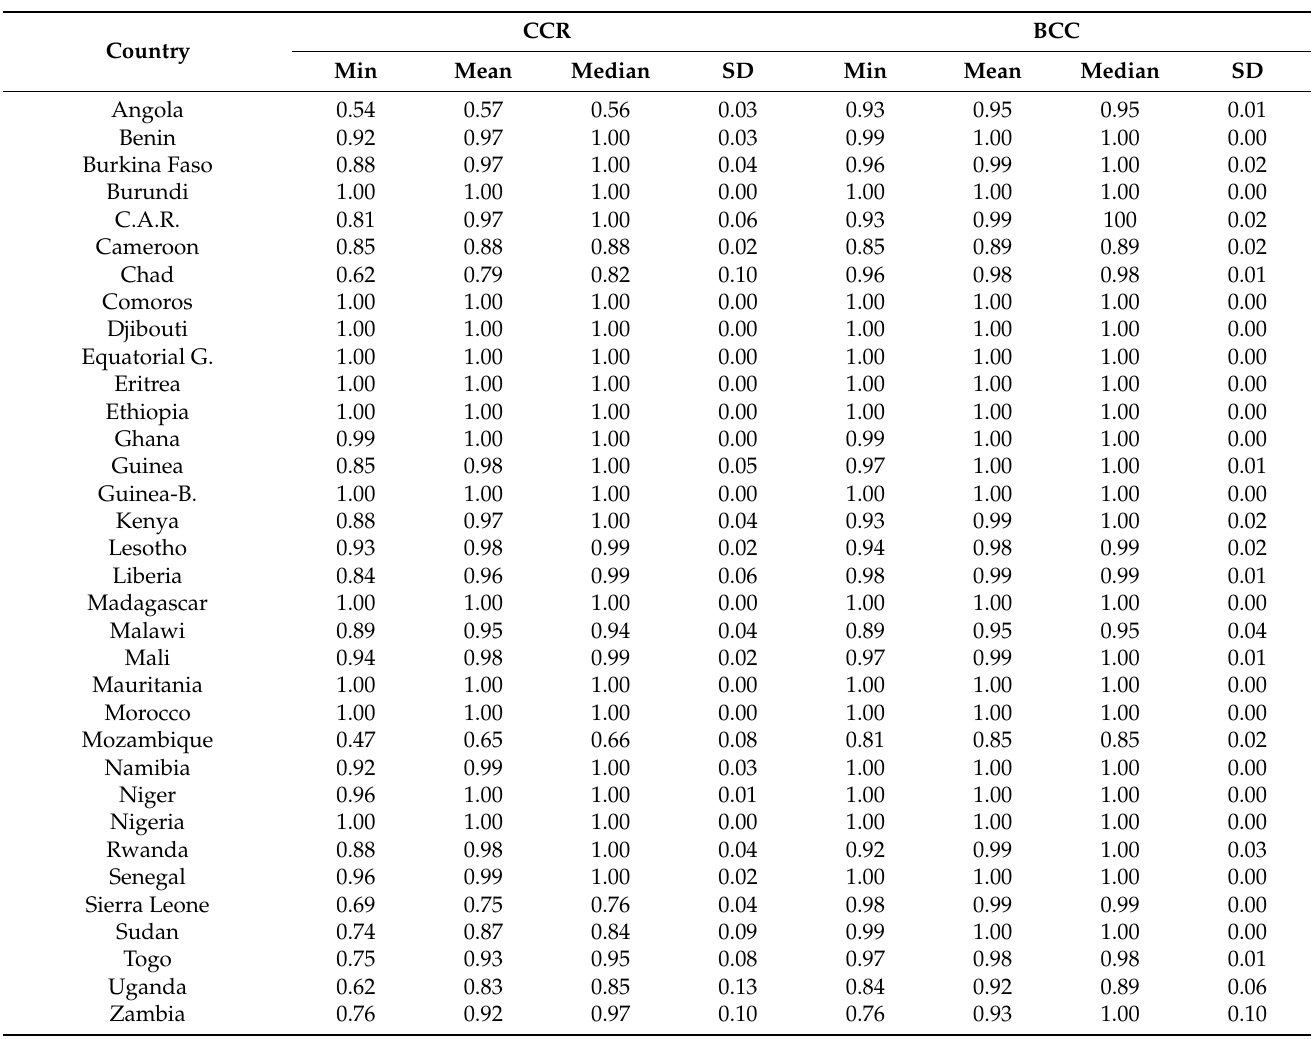
Table 3. Results for DEA model for national governments and agencies of